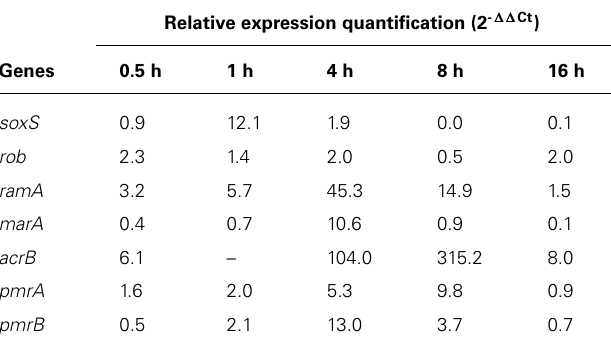
Table 2 |Activities of genes during transient inhibition of growth from exposure to 100 mg/L thioridazine (TZ) on Salmonella enterica serovar Enteritidis